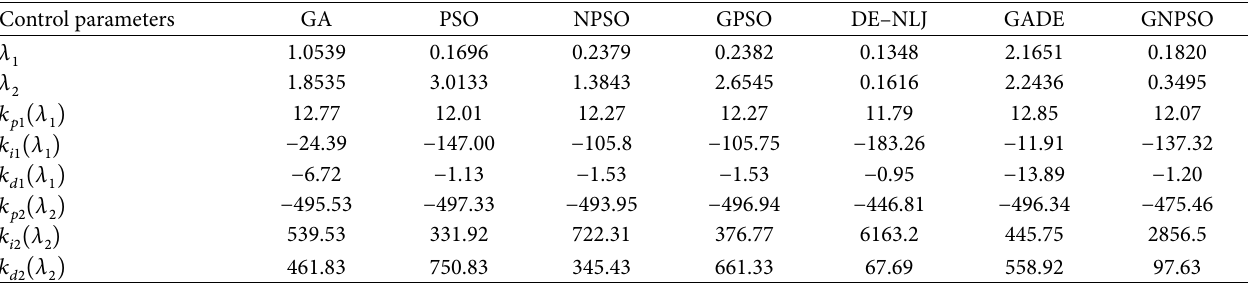
Table 15: Optimization results of IMC-PID controller parameters obtained by GA, PSO, NPSO, GPSO, DE–NLJ, GADE and GNPSO asso- for MIMO nonlinear wing vibration system. ciated with 𝐹 𝑚𝑎𝑥